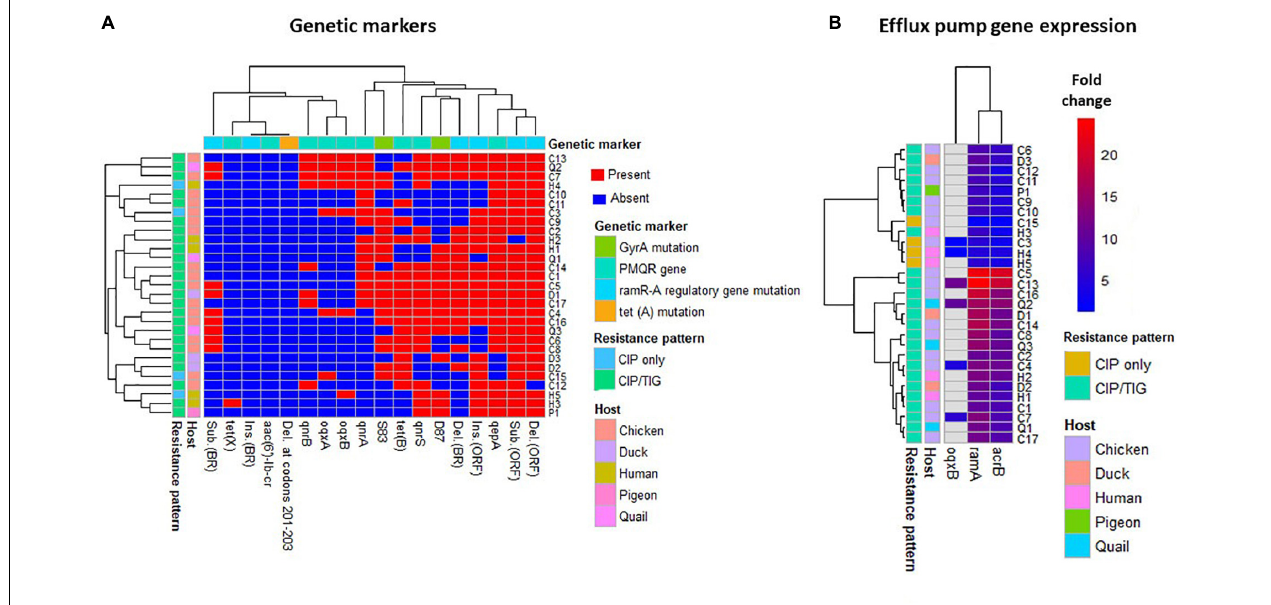
FIGURE 1 | Heatmap supported by hierarchical clustering (dendrogram) depicting the overall distribution of genetic markers (A) and efflux pumps gene expression (B) in the 29 XDR Salmonella isolates. The isolates are color-annotated based on their hosts (C, chicken; D, duck; H, human; P, pigeon, and Q, quails) and resistance pattern [i.e., to CIP, ciprofloxacin ( n = 4) and to both CIP and TIG ( n = 25)]. The genetic markers are color-annotated based on their type. BR, binding region; ORF, open reading